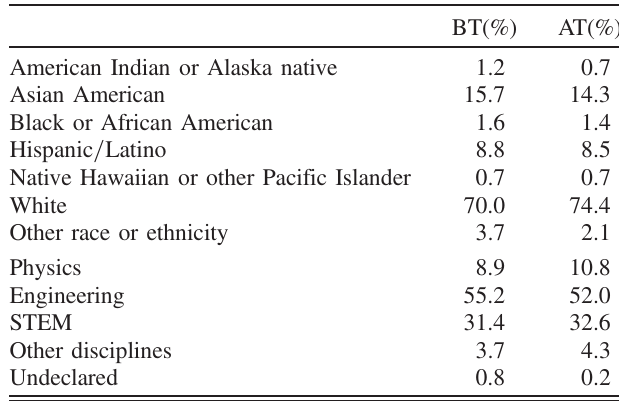
TABLE II. Demographic data of the women enrolled in the introductory physics lab course in its BT (Fall 2016 to Fall 2017) and AT (Spring 2018 to Fall 2019) format with N ¼ 522 . N AT